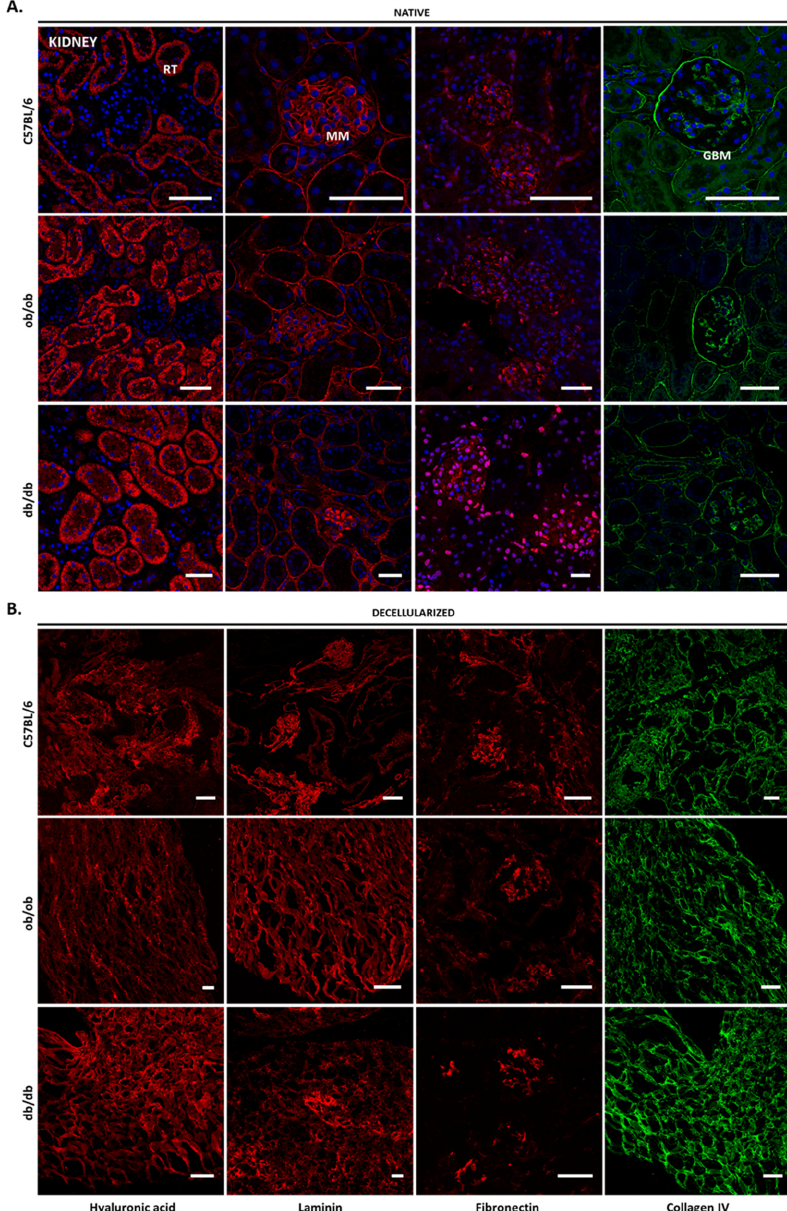
Figure 5. Kidney ECM components prior to and after decellularization. Representative confocal microscopy images of native ( A ) and decellularized ( B ) kidney sections from C57BL/6J, ob/ob, and db/db mice. Confocal microscopy images of immunostaining for hyaluronic acid (first column), laminin (second column), fibronectin (third column), and collagen IV (forth column). Nuclei are stained in blue (with DAPI). RT, renal tubules; MM, mesangial matrix; GBM, glomerular basement membrane. Scale bar: 100 µm.